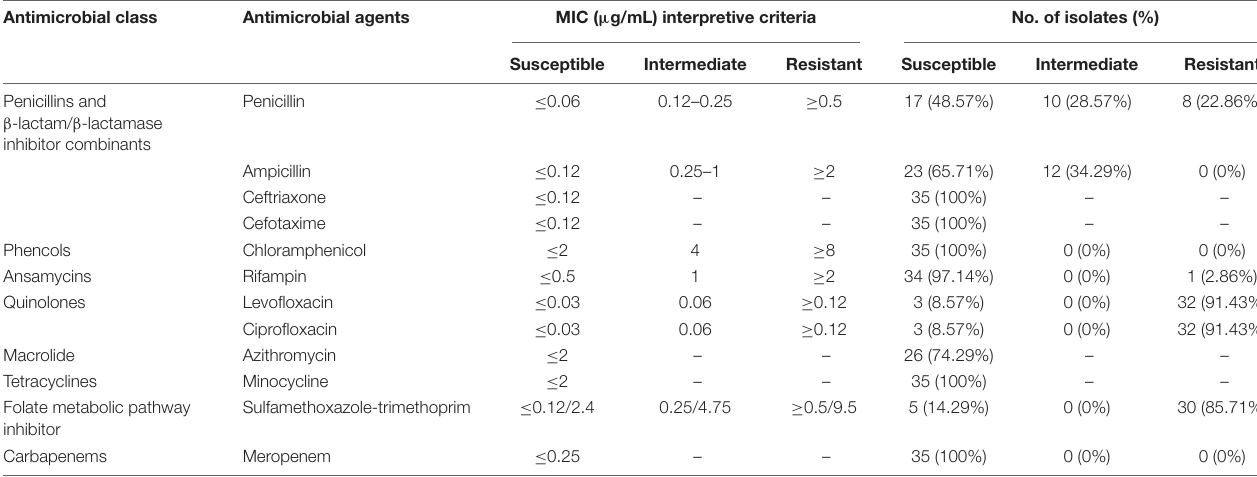
TABLE 4 | Antibiotic susceptibility of Nm isolates from both MD cases and